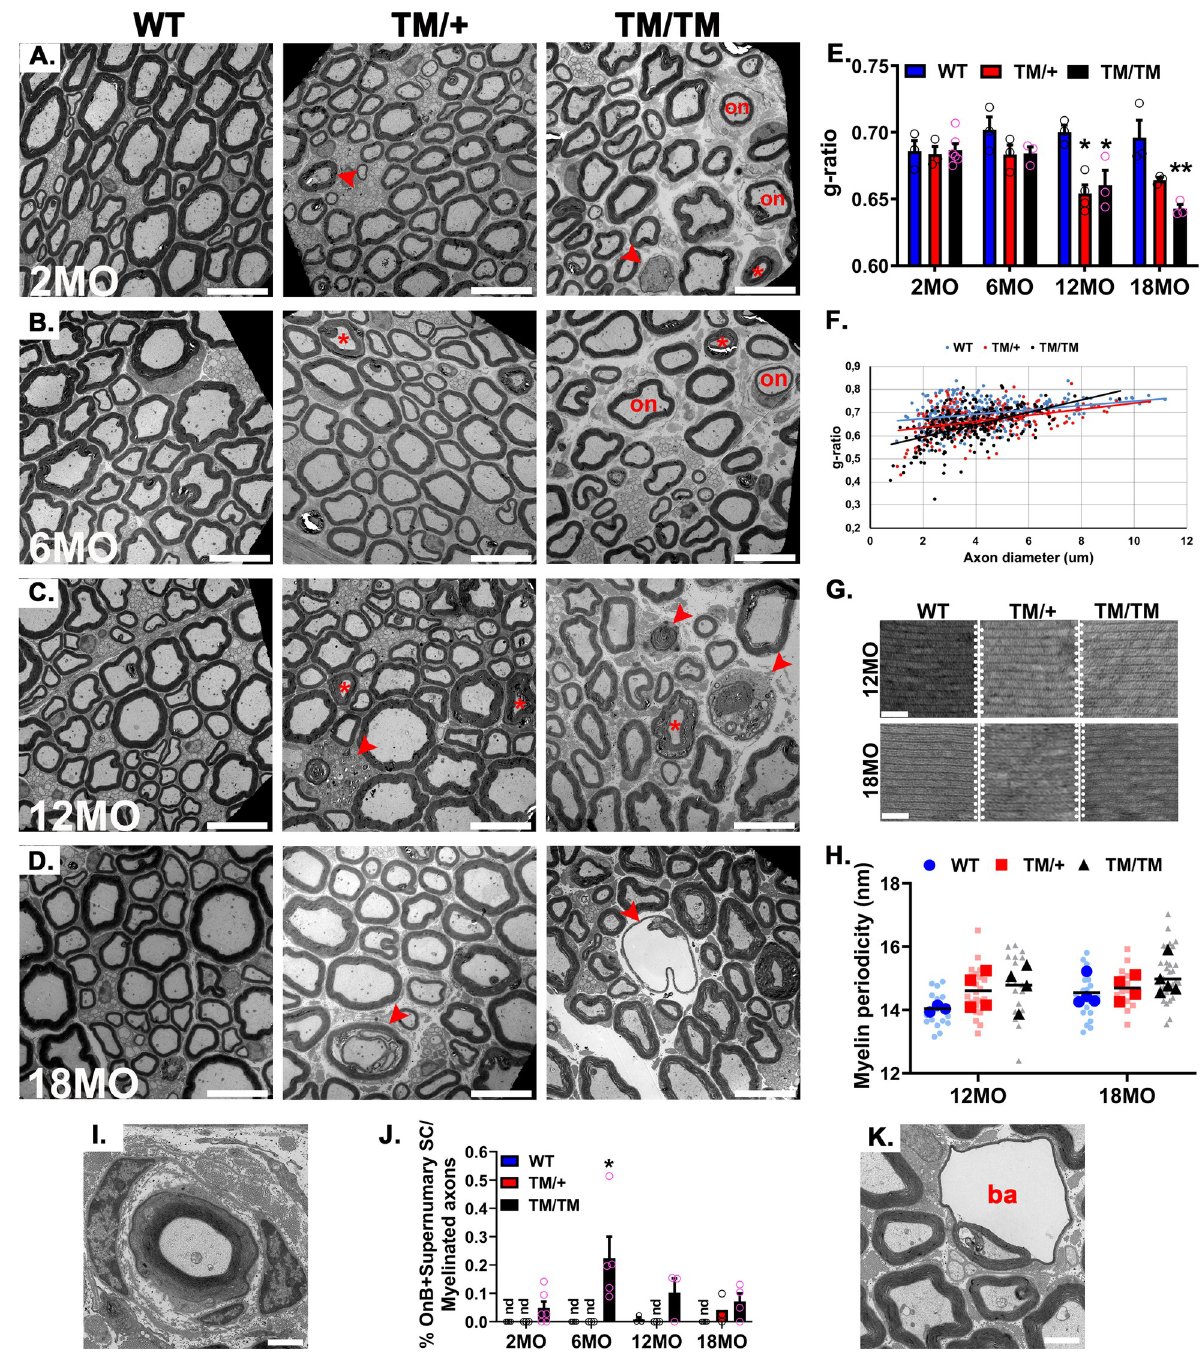
Fig 2. Morphological analysis of Mpz T124M nerves. ( A to D ) Representative electron micrographs of wild-type (WT), Mpz T124M/+ (TM/+), and Mpz T124M/T124M (TM/TM) sciatic nerve cross sections at 2 ( A ), 6 ( B ), 12 ( C ), and 18 ( D ) months of age. Arrowheads indicate degenerative figures, asterisks indicate SLI, and “on” indicate onion bulbs and supernumerary SC. Scale bars: 10 μ m. ( E ) g-ratio analysis shows hypermyelination of Mpz T124M fibers starting at 12 months of age. One-way ANOVA [2 month old: F (2, 9) = 0.0738, p = 0.9294; 6 month old: F (2, 6) = 1.994, p = 0.2168; 12 month old: F (2, 7) = 9.655, p = 0.0097; 18 month old: F (2, 6) = 11.8, p = 0.0083]. ( F ) g-ratio as a function of axonal diameter shows preferential hypermyelination of small fibers in Mpz T124M mice compared to that in WT mice. ( G ) Ultrastructural analysis of periodicity shows that myelin sheaths are well compacted in Mpz T124M mice. Scale bars: 50 μ m. ( H ) Myelin periodicity was slightly, but not significantly, increased in Mpz T124M mice. Nested one-way ANOVA [12 month old: F(2,8) = 1.702, p = 0.24; 18 month old: F(2,10) = 1.03, p = 0.392]. ( I ) Representative electron micrograph of an onion bulb. ( J ) Onion bulbs and supernumerary SC were rare in Mpz T124M/T124 mice. They represented 0.2% of myelinated fibers in